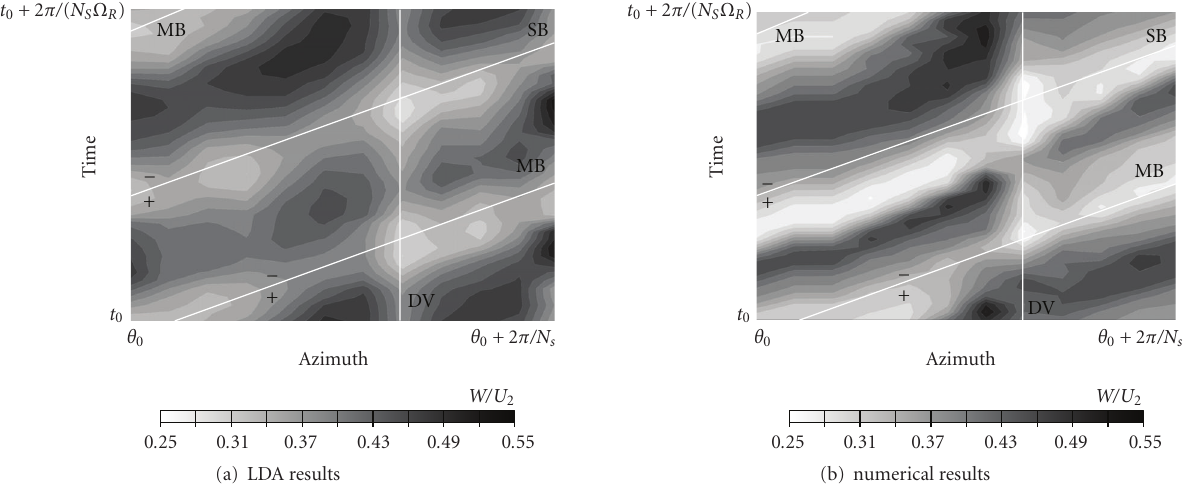
Figure 6: Reduced relative velocity at mid inter row gap and 70% section height, over a stator pitch and a rotor time period.